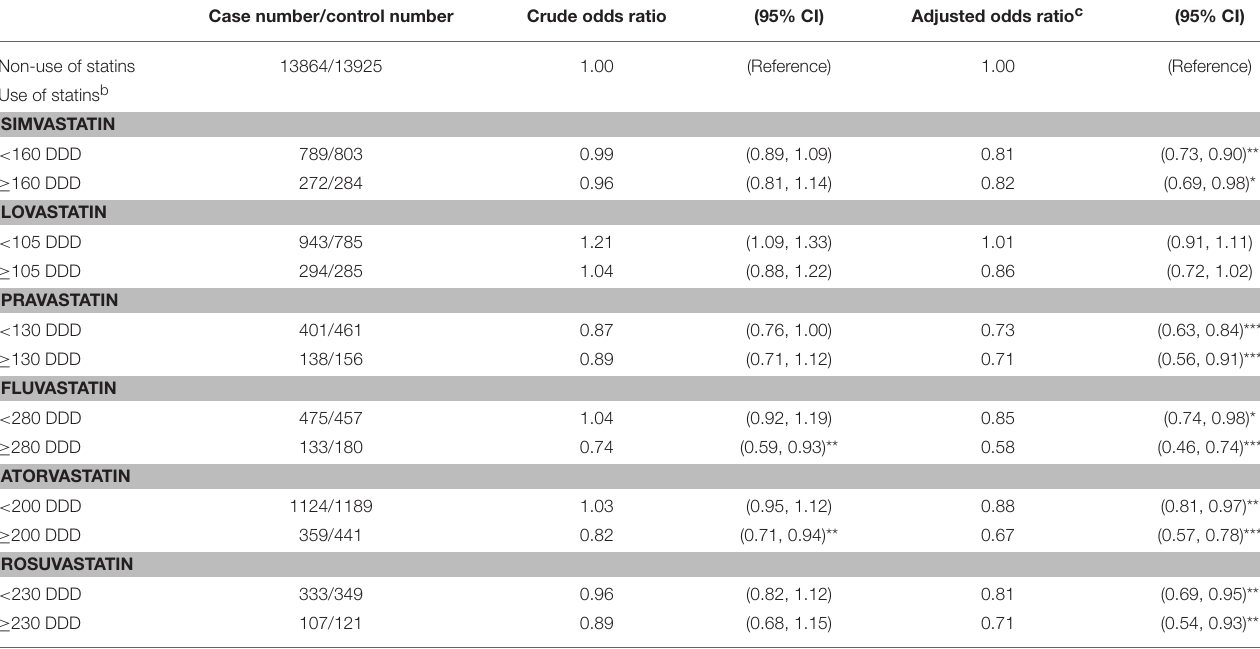
TABLE 3 | Prescribed statins reduce the risk of PUD a